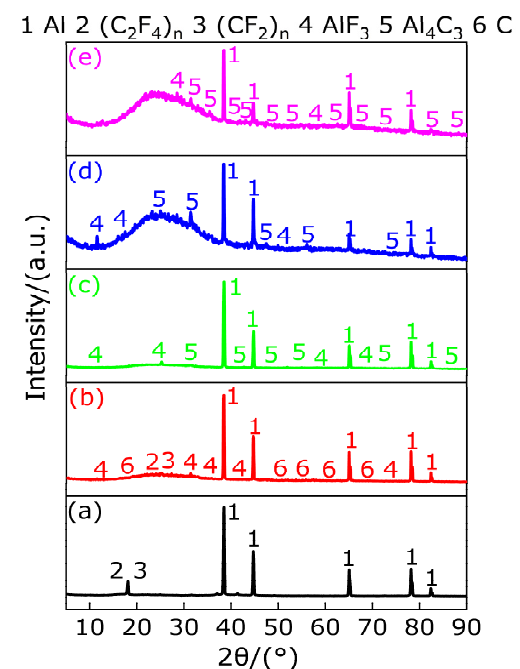
Figure 19. XRD patterns of the residues of Al/PTFE composites at the peak temperatures of peak A, B, C and D on the DSC curve and at 1000 °C. ( a ) XRD pattern at 338.9 °C; ( b ) XRD pattern at 560.8 °C; ( c ) XRD pattern at 660.6 °C; ( d ) XRD pattern at 903.1 °C; ( e ) XRD pattern at 1000 °C.